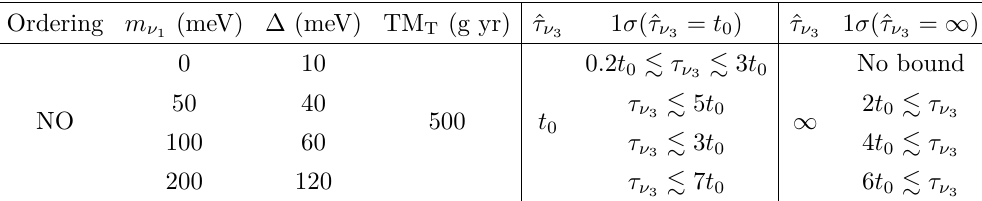
Table 3 . Marginalized constraints on the neutrino lifetime τ ν with fiducial values of ˆ τ = t and ˆ τ = ∞ in the NO case and for various values of the lightest ν 3 0 ν 3 neutrino mass, m , and of the detector resolution, ∆ . We assume an exposure of 500 g yr. ν 1 (ˆ τ ) = (2 t , ˆ m , 0) and (0 . 3 t , 0) , the distinguishable number of events for ν ν 3 0 0 φ